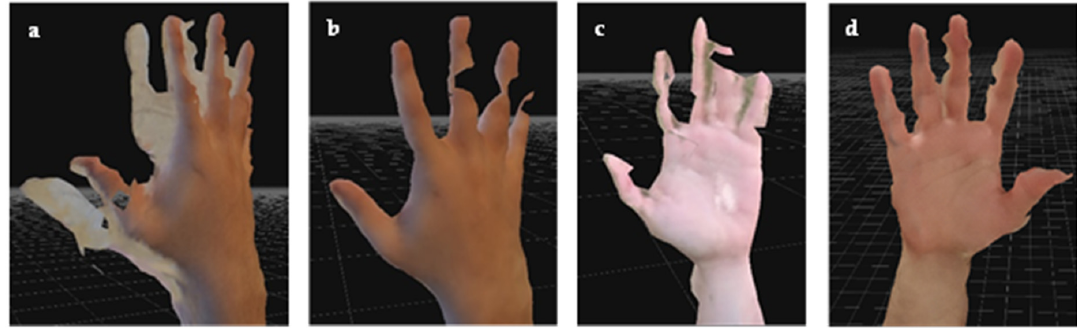
Figure 3. Different results of photographs inserted into 3DF Zephyr. ( a – d ) show different approaches, as described in the main text.